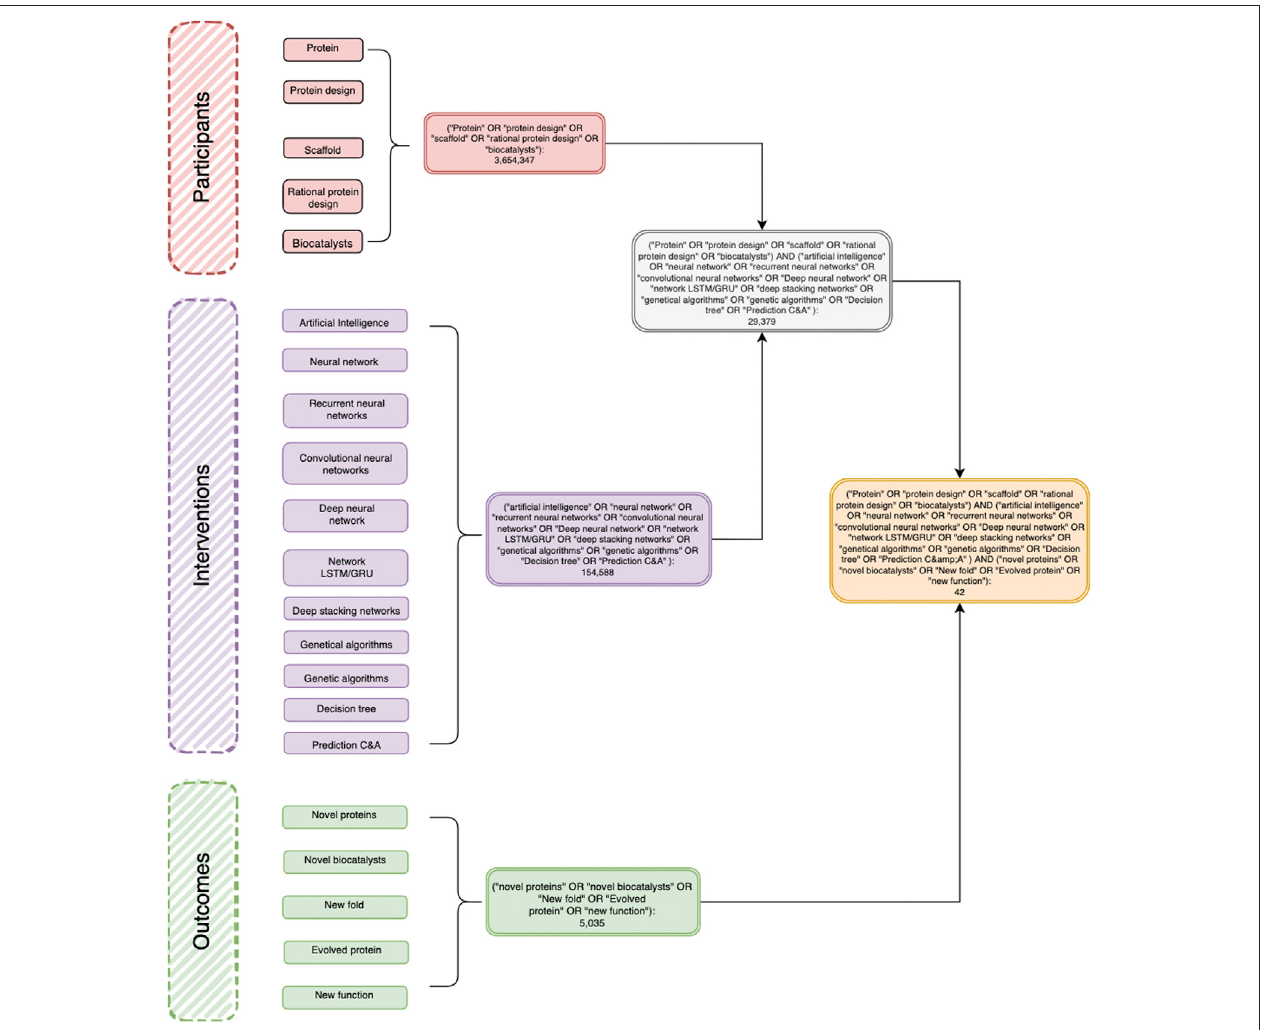
FIGURE 1 | A representative decision diagram showing the articles retrieved using the PIO strategy in the PubMed database. P (participants): Protein, Protein Design, Scaffold, Rational protein design, Biocatalysts. I (intervention): Networks: Neural networks, Recurrent neural networks, Networks LSTM/GRU, Convolutional neural network, Deep belief networks, Deep stacking networks C5.0; Genetic algorithms; Arti fi cial intelligence; Decision trees; Classi fi cation; Prediction C&A; Software: Weka, RapidMiner, IBM Modeler; Programming Languages: Python, Java, OpenGL, C++ Shell; Development platform: Caffe Deep Learning, TensorFlow, IBM Distributed Deep Learning (DDL); Paradigm: Supervised Learning, Unsupervised learning, Reinforced learning, new function.